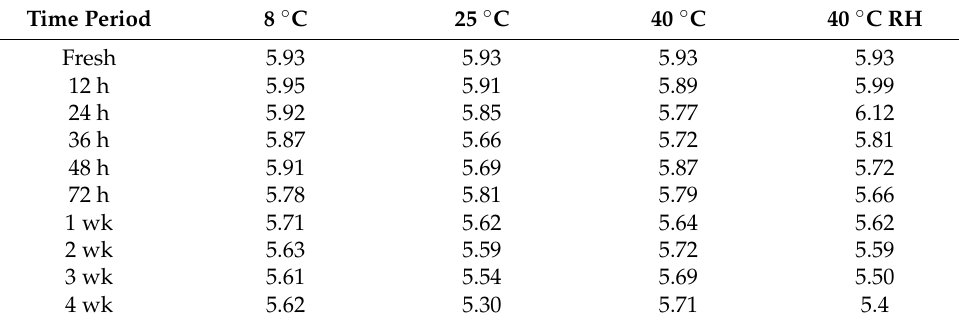
Table 5. pH values of optimized F5 formulation at 8 ◦ C, 25 ◦ C, 40 ◦ C, and 40 ◦ C